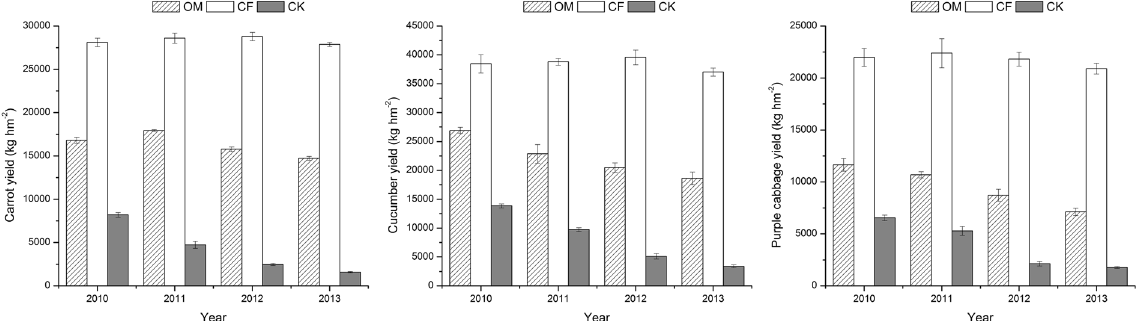
Figure 1. Changes in the different types of vegetable yields under the different fertilizer treatments during the 4 years of